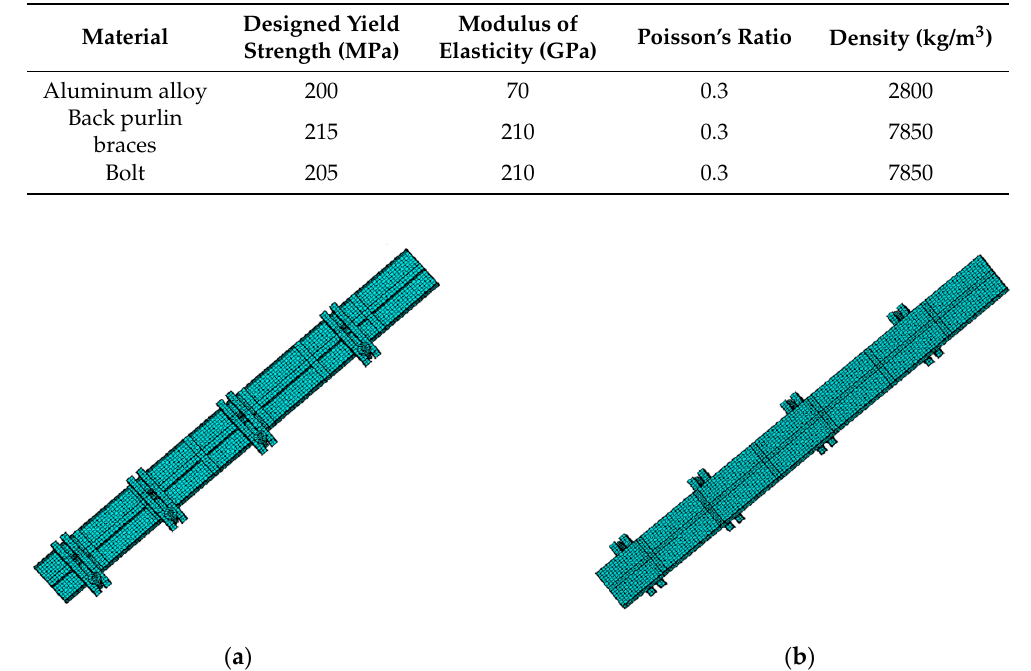
Figure 8. FEM model of formwork: ( a ) outside view; ( b ) inside view.